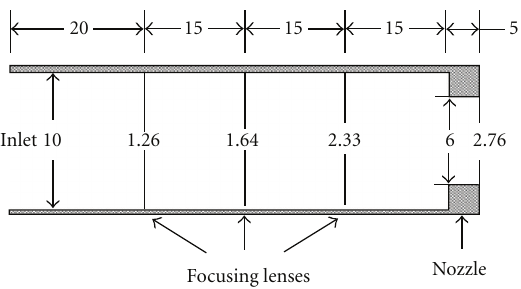
Figure 12: Schematic of aerodynamic lens system for focusing aerosol particles (dimensions in mm), from Wang et al. [85], Aerosol Science and Technology, Copyright 2005, Mount Laurel, NJ. Reprinted with